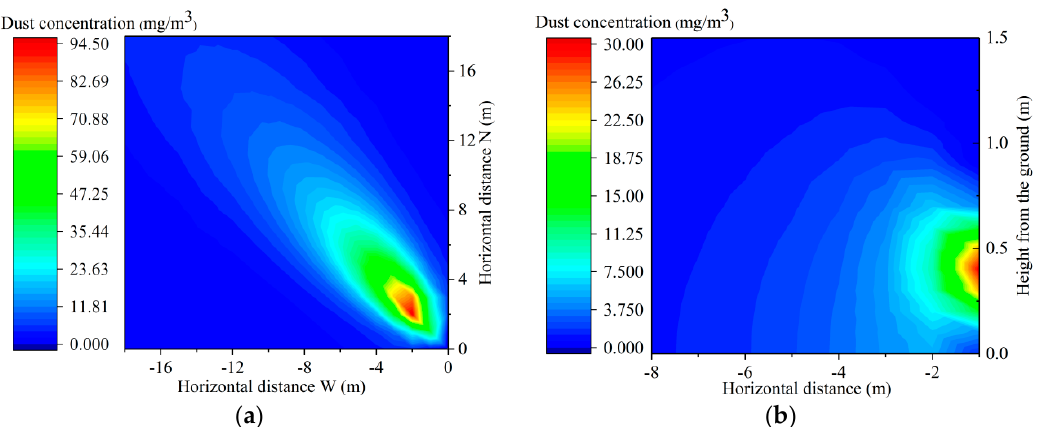
Figure 3. Spatial distribution of dust concentration in the stope shovel loading ( a ) is in horizontal direction, and ( b ) is in vertical direction.